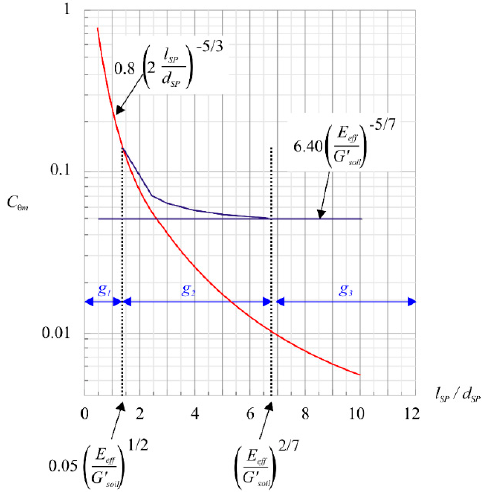
Figure 8. Influence factor curve of rotation within the entire range.